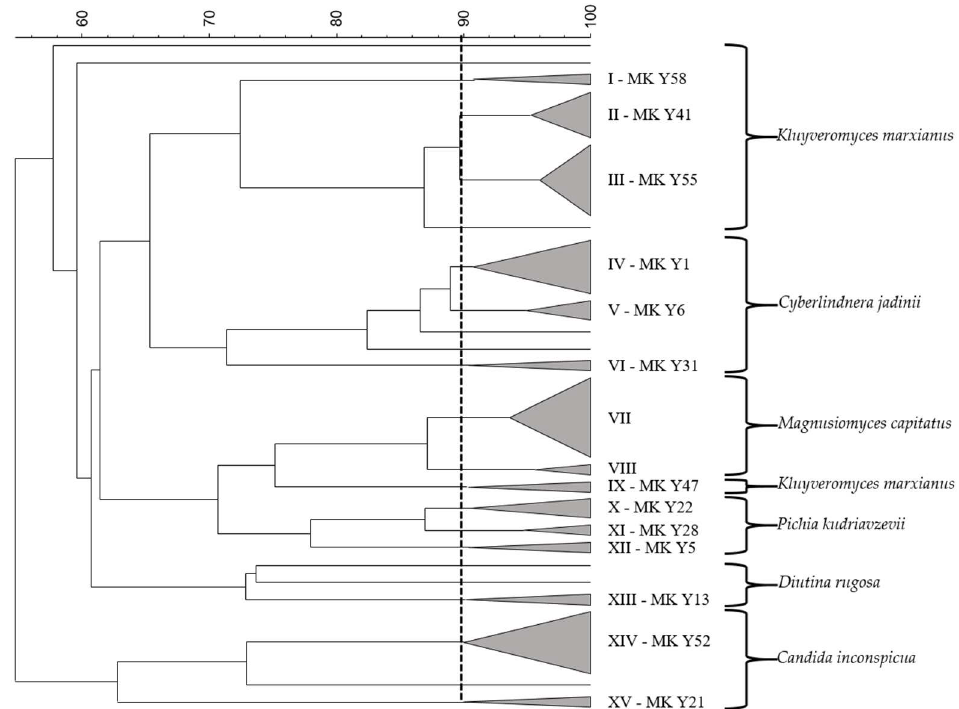
Figure 1. UPGMA dendrogram derived from comparison of the RAPD–PCR patterns obtained with primer M13 for the tested yeast isolates. The vertical red dotted line indicates the 90% of similarity level.